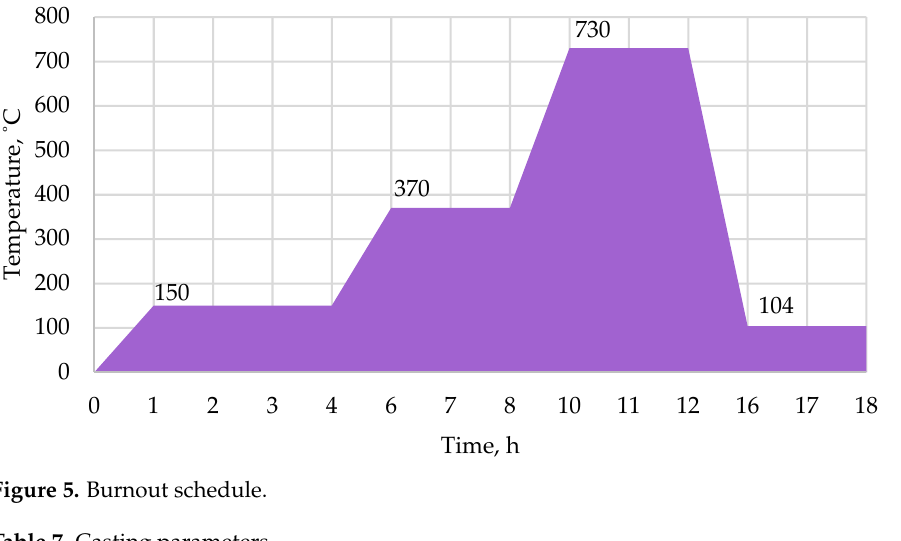
Figure 5. Burnout schedule. Table 7. Casting parameters. Casting Parameters Parameter Values Casting